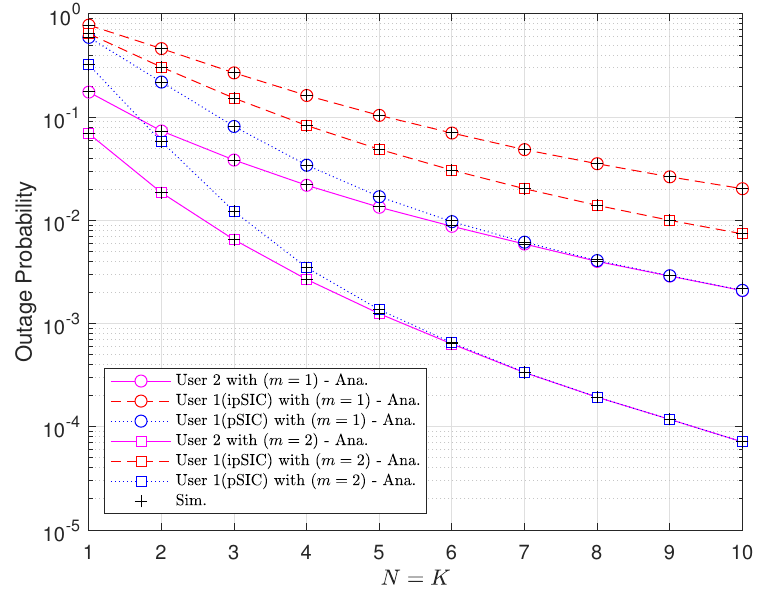
Figure 5. Outage probabilities with respect to the number of antennas at each vehicle with ρ = 10 [dB].